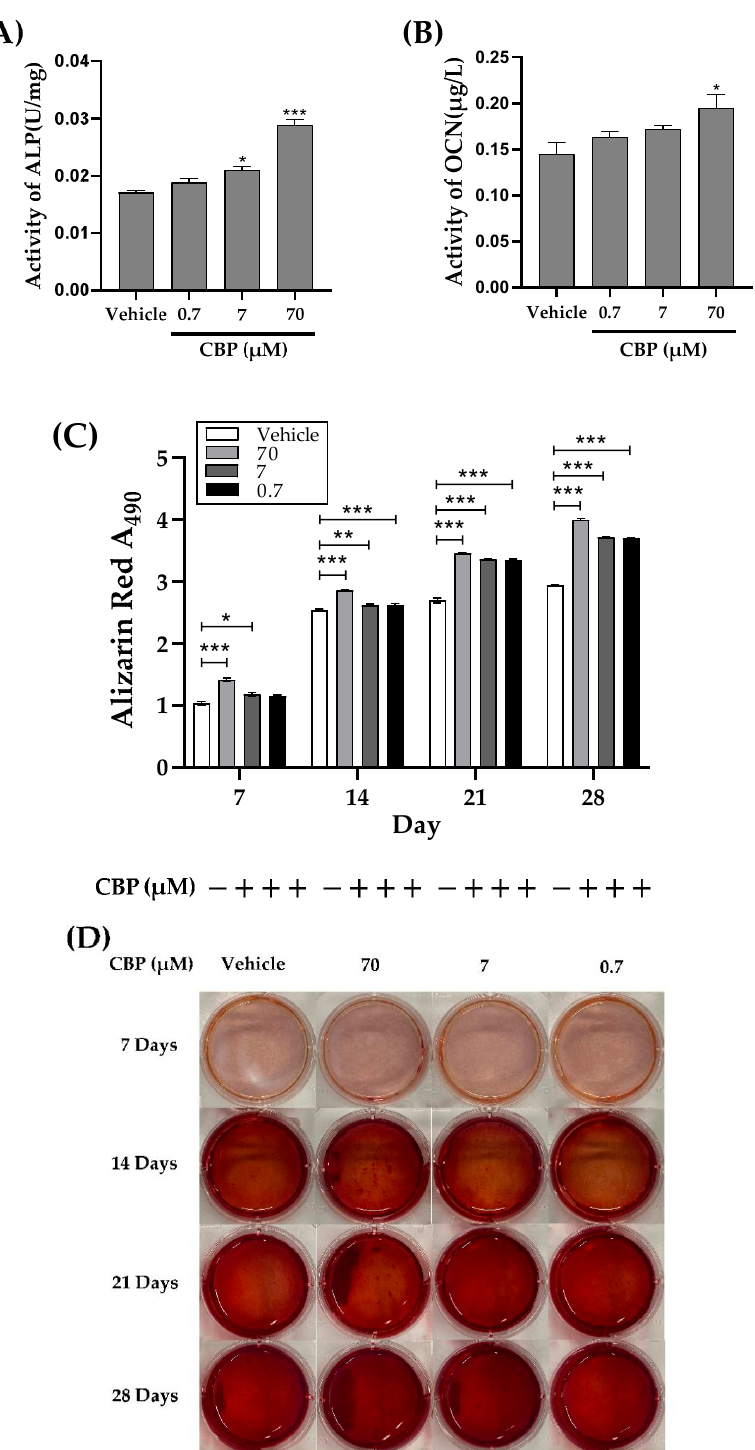
Figure 2. Effects of CBP on differentiation and mineralization in osteoblast cell MC3T3-E1. ( A ) Effect of CBP (0.7, 7, 70 µ M) on alkaline phosphatase (ALP) activity at 24 h. ( B ) Effect of CBP (0.7, 7, 70 µ M) on osteocalcin (OCN) at 24 h. ( C , D ) Cells were cultured with CBP (0.7, 7, 70 µ M) (+) or without ( − ) CBP with a differentiation medium including 10 µ M β -Glycerol phosphate and 50 µ g/mL L-ascorbic acid for 7–28 days. Then, cells were stained with an Alizarin Red S Staining Kit, and images were captured. After cell destaining with cetylpyridinium chloride in sodium phosphate, the absorbance was measured at 490 nm. Data are mean ± SEM from 3 independent experiments. * p < 0.05, ** p < 0.01, and *** p < 0.001 vs.